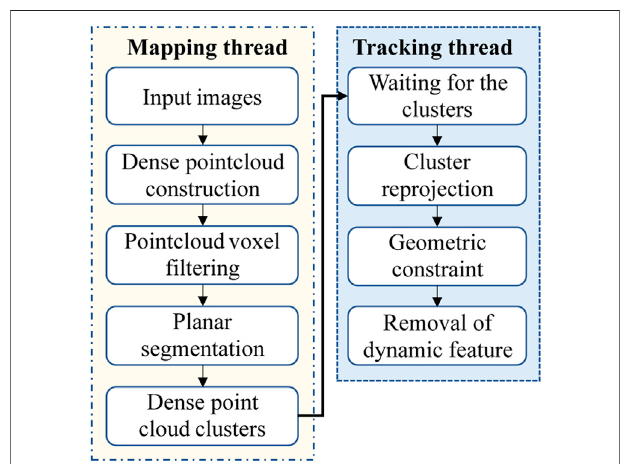
FIGURE 8 | The process of the rejection of dynamic objects. The presented mapping thread is illustrated in the yellow border which contains special operations on point clouds while thetracking thread isillustratedin the blue border which was improved to perform the task of dynamic keypoints